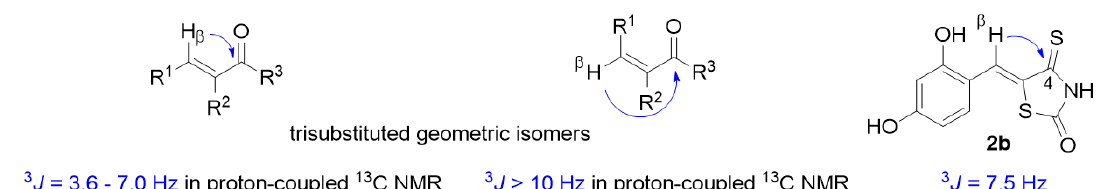
Figure 2. Relationship between the geometry of the double bond and C,H-spin-coupling constants over three bonds and the 3 J value at C(4) of compound 2b .